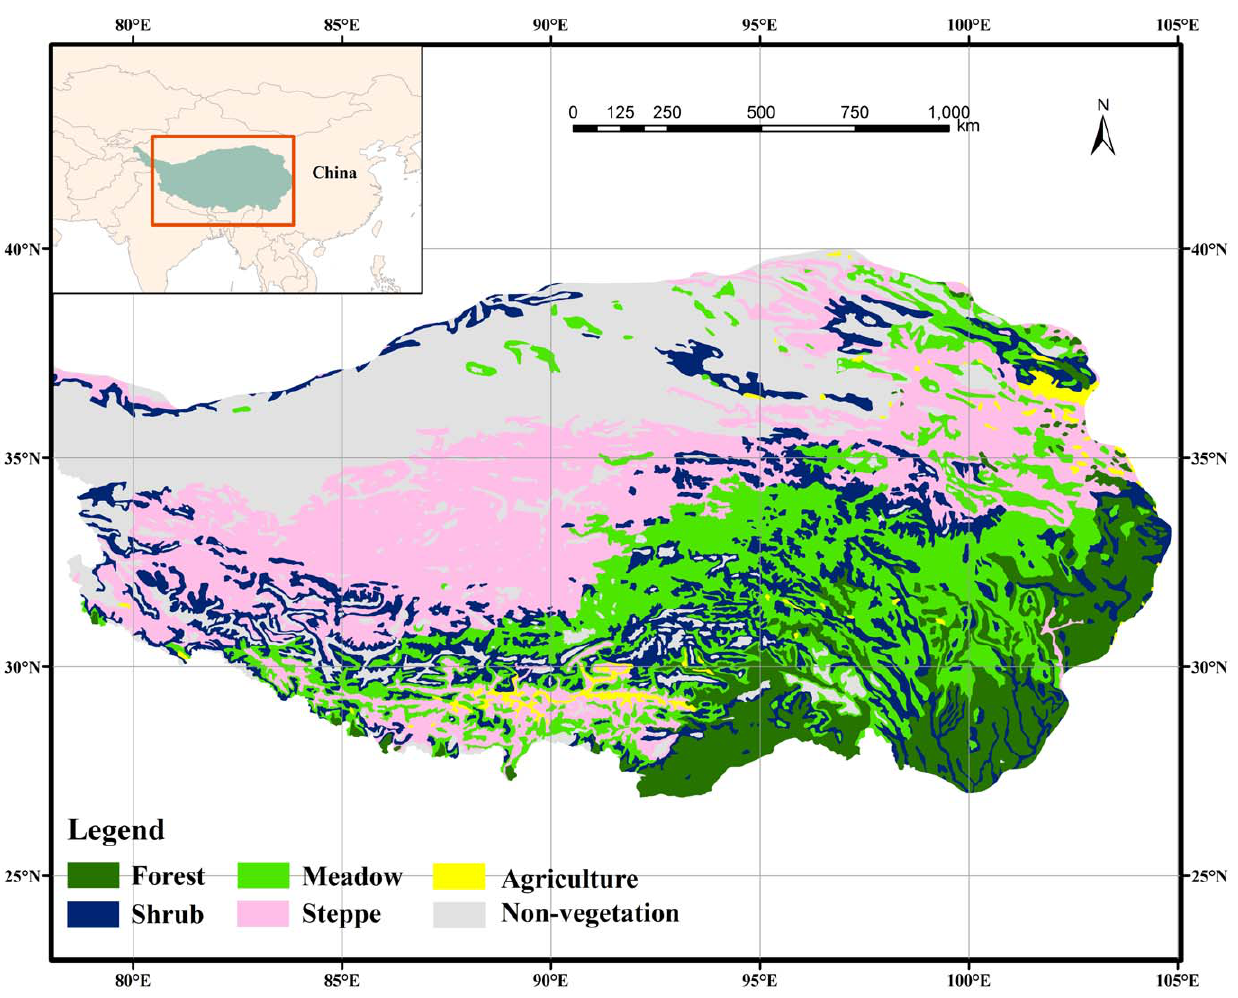
Figure 1. Overview map of the Tibetan Plateau in southwestern China, showing the different vegetation types present in the region.